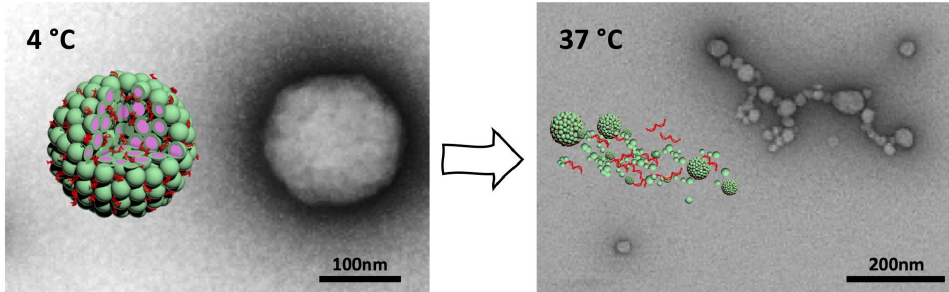
Figure 9. Schematic representation and TEM micrograph of the self-assembled (HR)3gT multi- compartment micellar nano-assembly (MCM) at 4 ◦ C ( left ) and temperature-induced disassembly of MCMs into disperse or clustered smaller MCMs and individual micelles at 37 ◦ C ( right ). Modified from [20] with permission from the Royal Society of